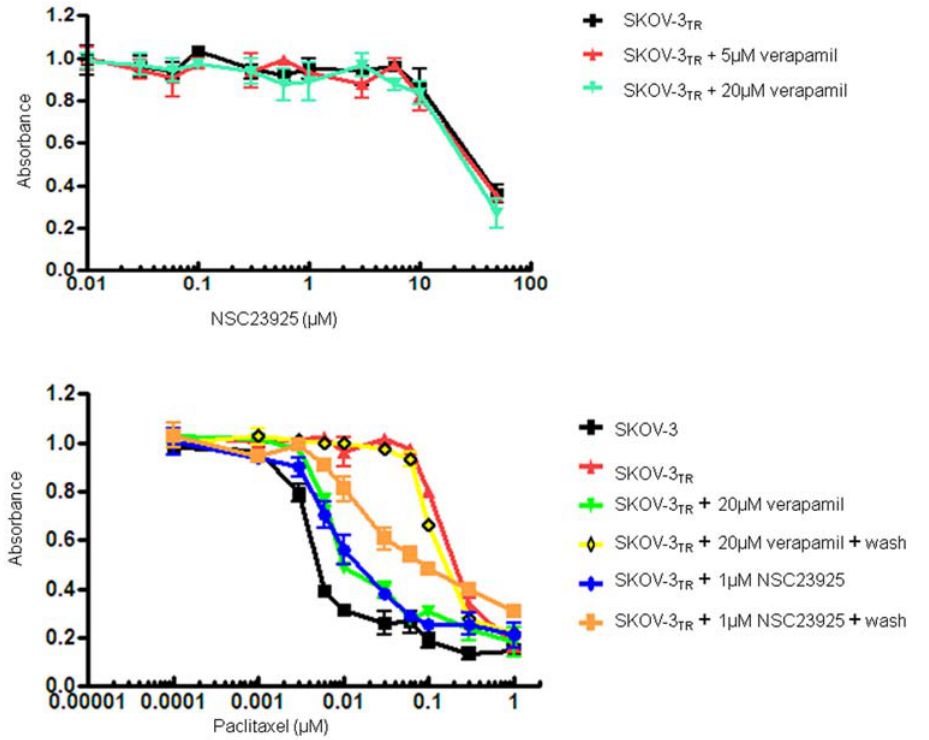
Figure 5. Effect of verapamil on NSC23925 sensitivity in Pgp1-overexpressing cells and persistence of NSC23925 activity. A : Effect of verapamil on NSC23925 sensitivity in SKOV-3 TR cells. SKOV-3 TR cells were treated with different concentration of NSC23925 alone or in combination with verapamil for 72 hours. Drug cytotoxicity was determined by MTT assay as described in the Materials and Methods. B : Persistence of NSC23925 reverses paclitaxel resistance in SKOV-3 TR cells after incubation and washout of NSC23925 or